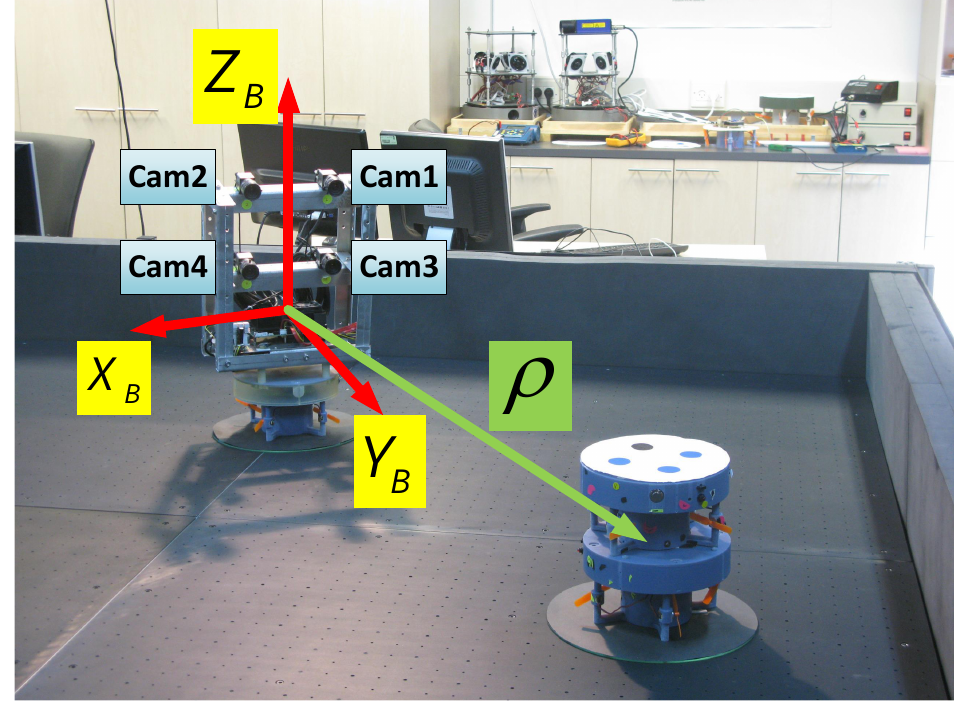
Figure 11. The body frame, camera numbers and LOS vector, shown in the laboratory